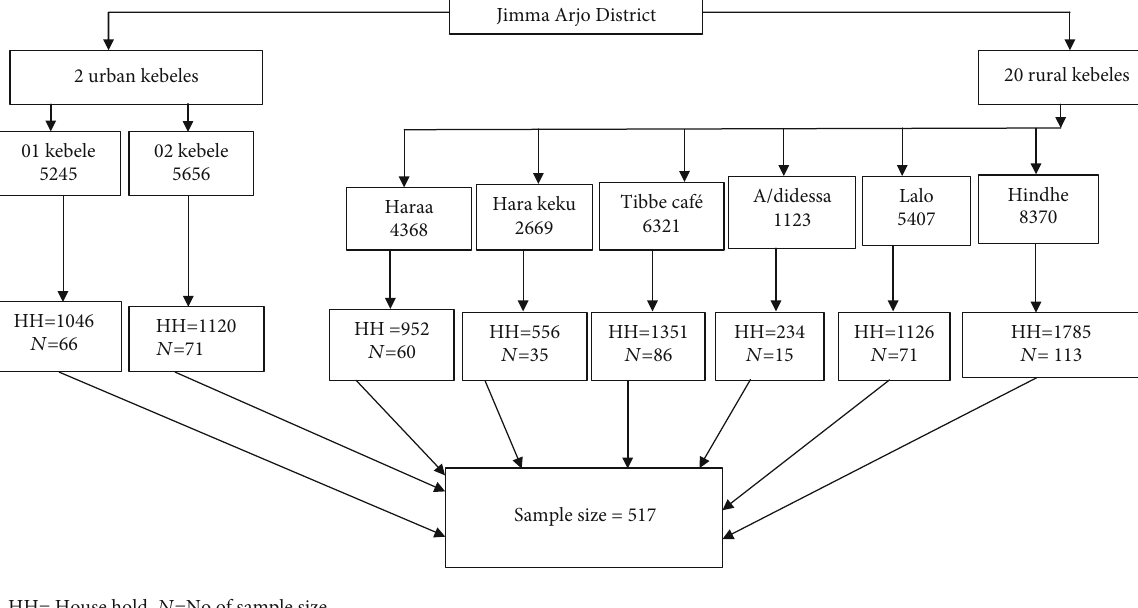
20 rural kebeles